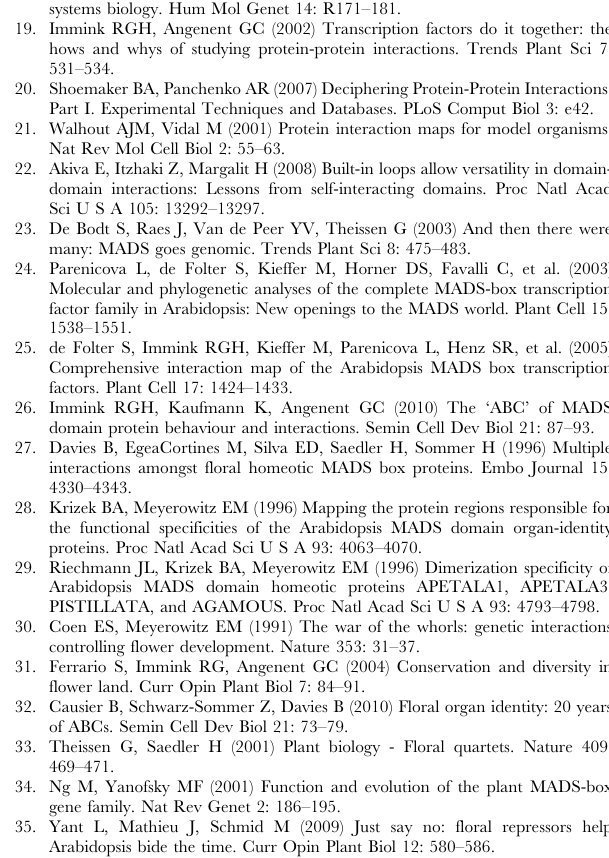
Table S2 Interaction data from additional species. Table S3 Prediction of large-scale MADS interaction data. Table S4 Interaction prediction for SEP-homologs.